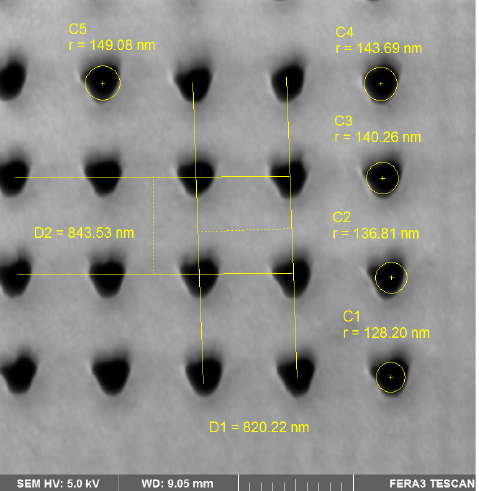
Figure 1. SEM micrograph of a corner part of the grid drilled in Au layer; the main dimensional parameters are shown and measured (SEM voltage 5 kV, SE imaging mode, magnification 50,000 × ); the shown scale is 1 µm long.